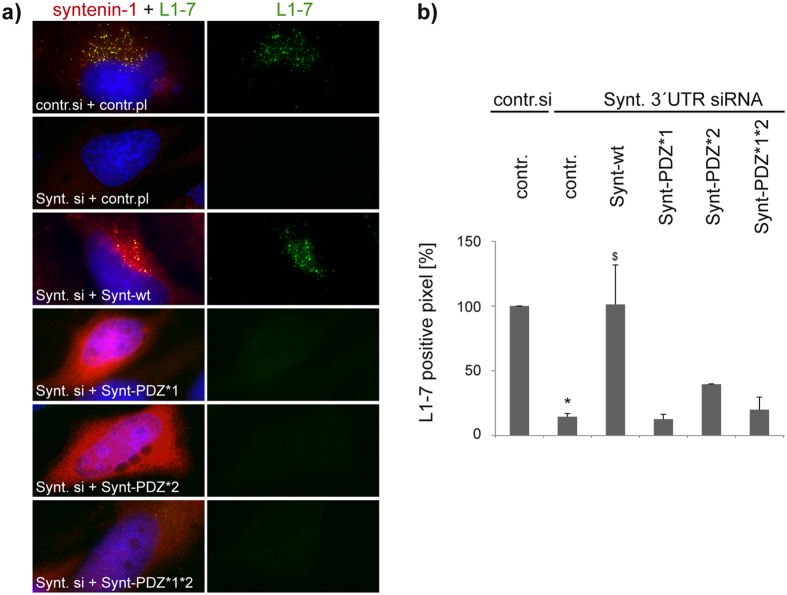
CD63-binding deficient mutants of syntenin-1 fail to recover L1-7 reactivity.Syntenin-1-depleted HeLa cells were transfected with control or syntenin-1 expression plasmid as indicated, infected with HPV16 and sequentially stained with 33L1-7 and syntenin-1 antibodies. L1-7 reactivity assays were performed as in Fig. 2e,f. (a) Shows representative pictures of 33L1-7 and syntenin-1 immunostaining. (b) Shows quantification of L1-7 reactivity. *P < 0.05 significant decrease compared to control, $P < 0.05 significant increase compared to cells transfected with CD63 siRNA and control plasmid.